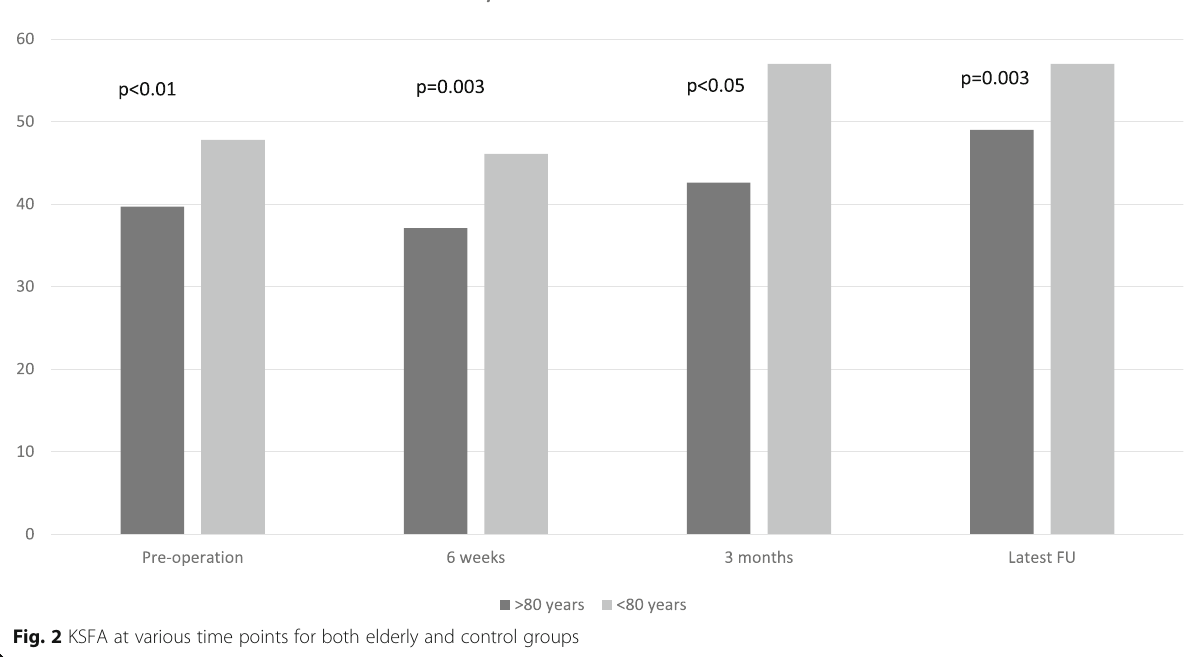
Table 2 The incidence of different types of complications in the elderly and control groups Type of complication Elderly patients